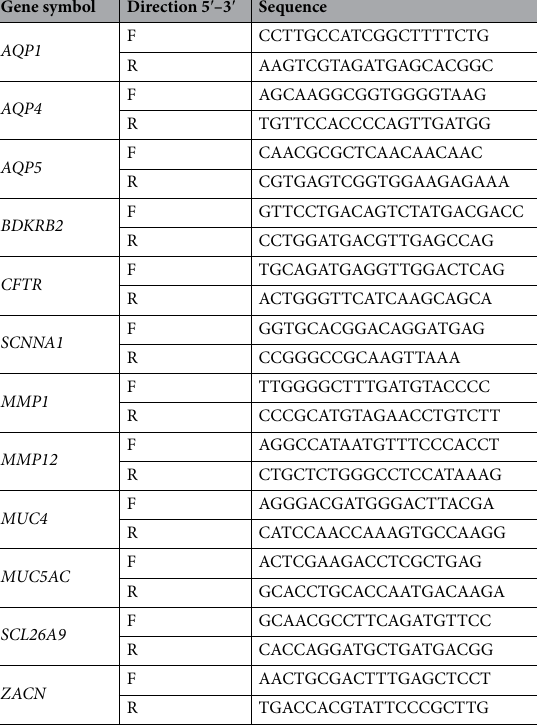
Table 1. qPCR primers used in this